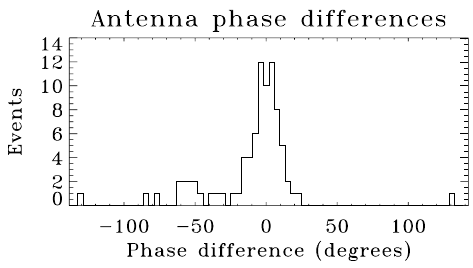
Fig. 2. Histogram of antenna phase